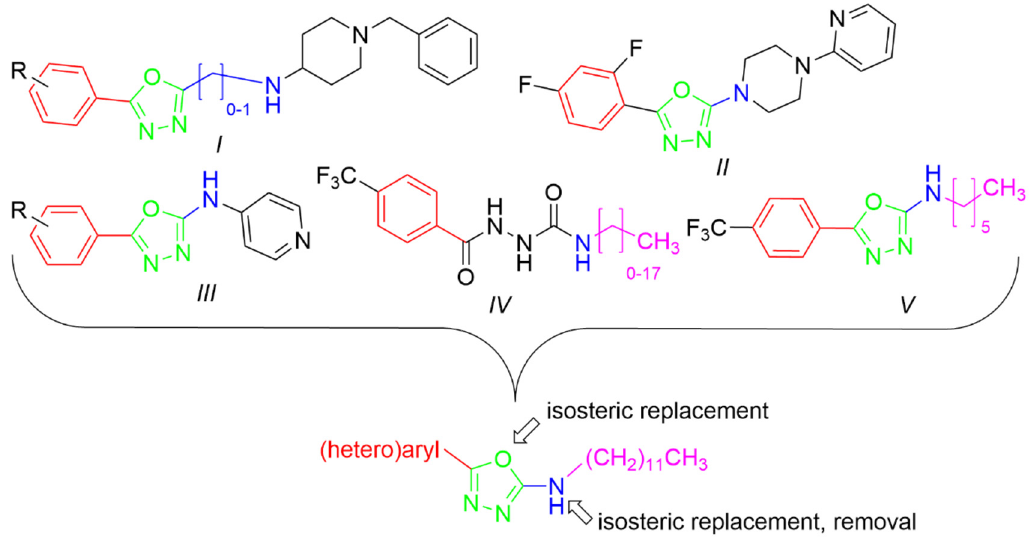
Figure 1. Structural fragments involved in the structure of targeted derivatives and their design: 1,3,4-oxadiazoles, long alkyl, aryl, and amine/amide linker.